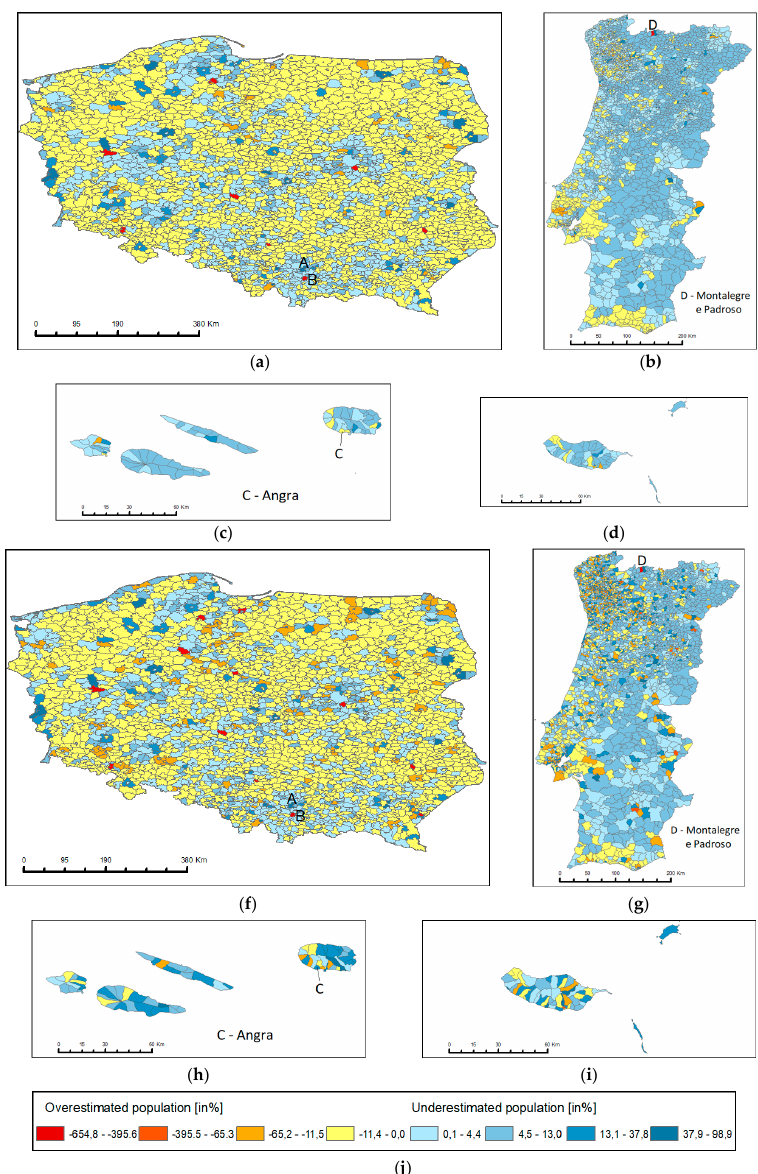
Figure 11. LAU 2 (NUTS 5): MAPE. ( a ) GHS-POP 250 m, Poland; ( b ) GHS-POP 250 m, Portugal; ( c ) GHS-POP 250 m, Azores; ( d ) GHS-POP 250 m, Madeira; ( f ) GHS-POP 1 km, Poland; ( g ) GHS-POP 1 km, Portugal; ( h ) GHS-POP 1 km, Azores; ( i ) GHS-POP 1 km, Madeira; ( j ) legend.